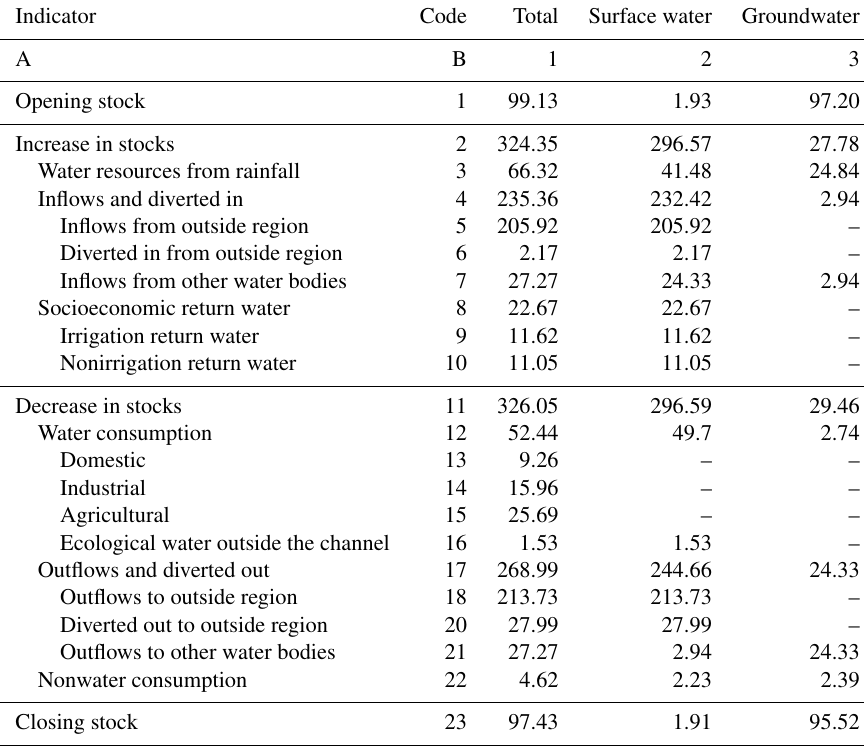
Table 2. The physical accounts of water resources of Chengdu in 2015, measured in units of 100millionm 3